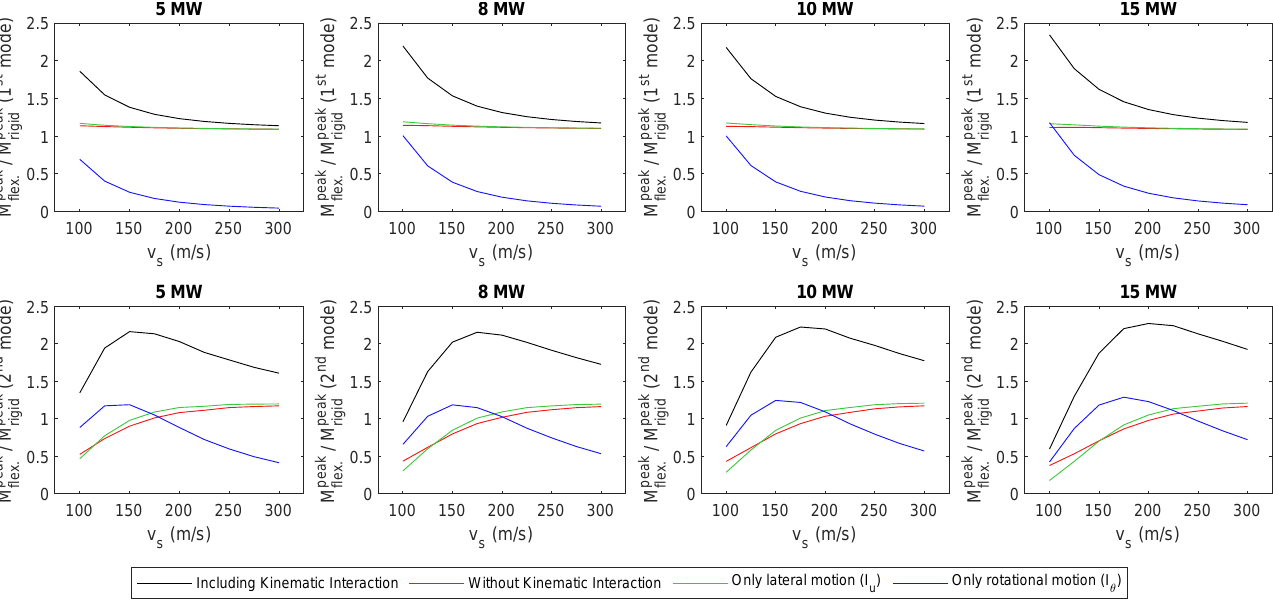
Figure 11. Peak values of the Frequency Response Functions for the bending moment at the mudline level corresponding to the first two modes. Analysis of the influence of the kinematic interaction and the soil